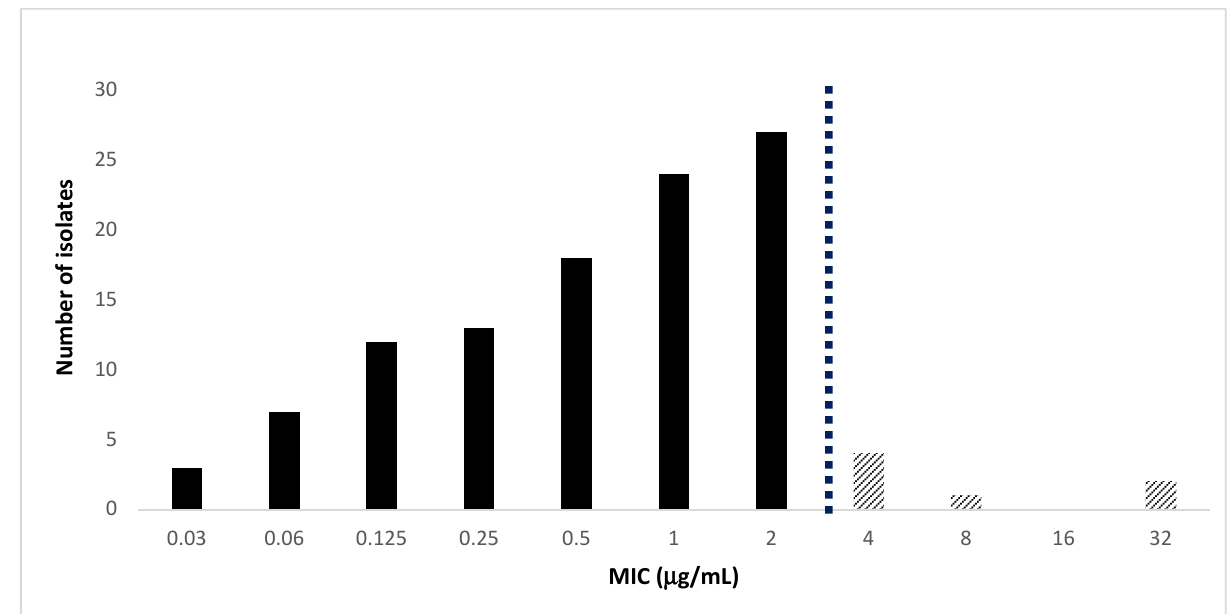
Figure 1. Distribution of cefiderocol MICs for all of the isolates according to EUCAST breakpoints. Black column, susceptible isolates; striped columns, resistant isolates. The dashed bar separates susceptible and resistant isolates.